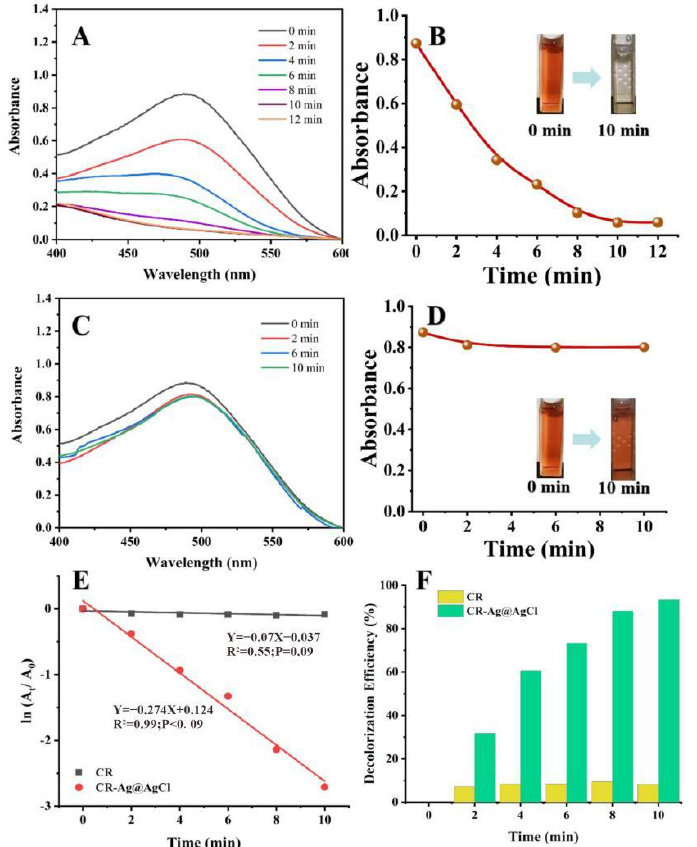
Figure 6. The reduction of CR in aqueous solution recorded every 2 min: the Uv-vis spectral of CR reaction with Ag@AgCl nanoparticles ( A ) and without ( C ); Digital images of CR reaction with Ag@AgCl nanoparticles ( B ) and without ( D ); ln(A t /A 0 ) versus reaction time for CR reduction ( E ); Decolourization efficiency versus reaction time for CR reduction ( F ).